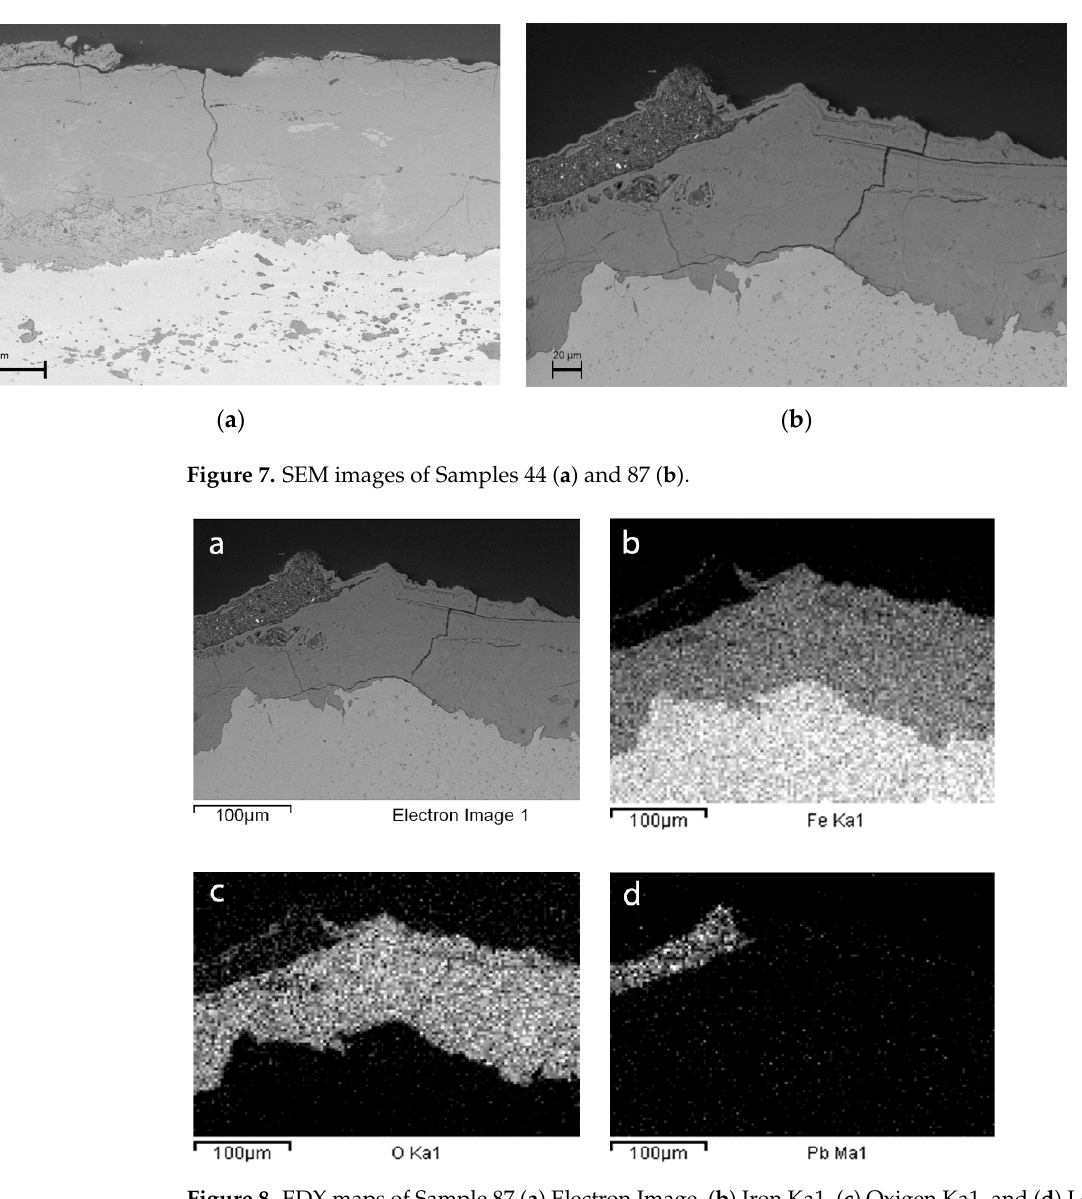
Table 3. Corrosion products detected by Raman spectroscopy and XRD on the San Carlone sam- ples.